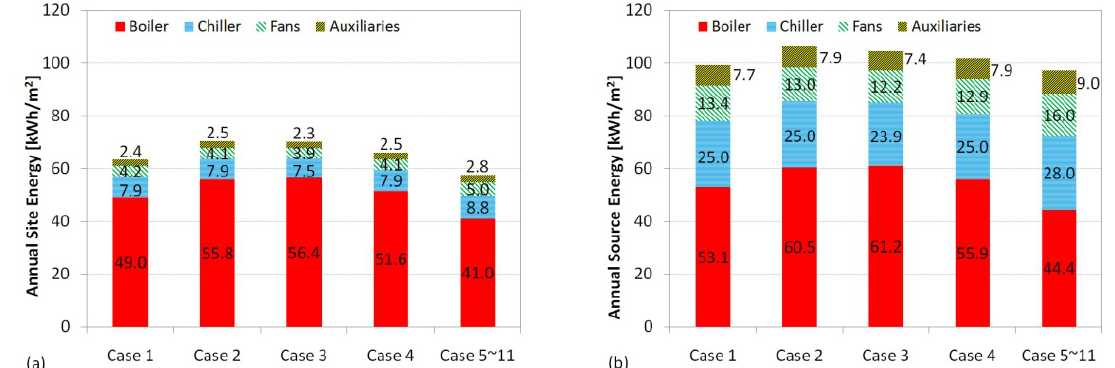
Figure 6. Annual energy breakdown (boiler, chiller, fans, auxiliaries) for ( a ) site and ( b ) source–primary